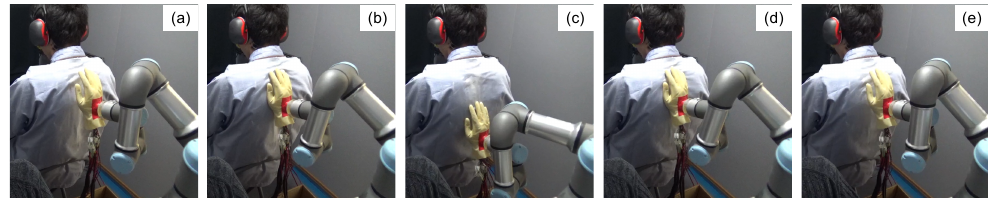
Figure 4. The flow of the robot stroke motion. ( a ) Move towards the back. ( b ) Contact the back and keep pressure. ( c , d ) Stroke the back and return. ( e ) Leave the